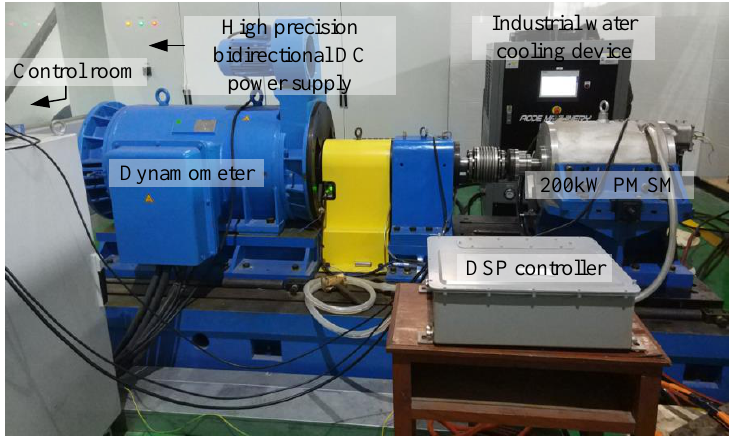
Figure 9. Prototype temperature rise test platform.